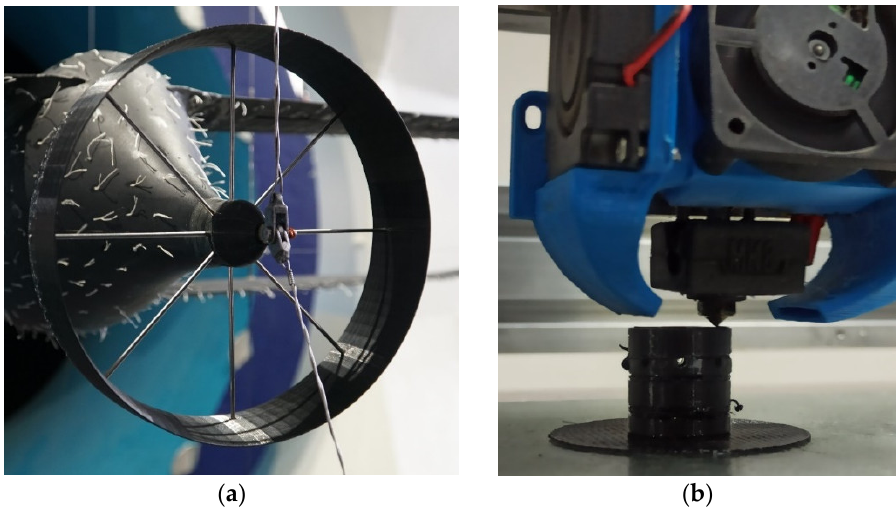
Figure 5. ( a ) Aft duct fixed on spokes linked with a hub; ( b ) process of 3D printing of the duct hub.